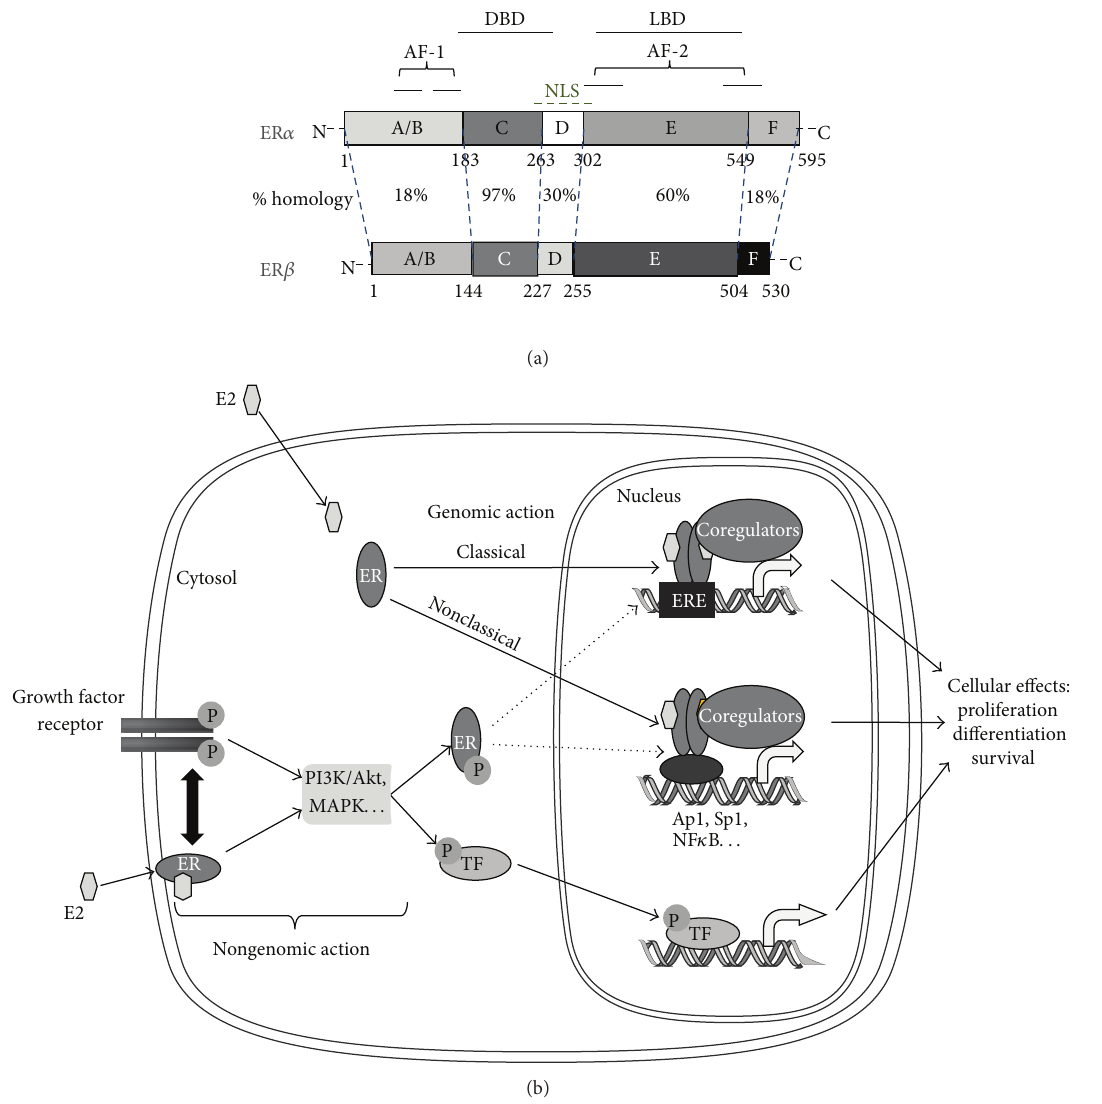
Figure 2: Structure and mechanisms of action of estrogen receptors. (a) ER 𝛼 and ER 𝛽 have an evolutionary conserved modular structure. The percentages of homology between the two forms are presented. The localizations of the ligand-binding domain (LBD) within the E domain and the DNA-binding domain (DBD) within the C domain are also presented. ERs possess two transactivation functions (AF-1 and AF-2), each divided into two subdomains which regulate the expression of target genes and contain a nuclear localization signal (NLS). (b) Due to its lipophilic properties, estradiol (E2) can passively enter the cell, through the lipid membranes. E2 can then bind ERs in the cytoplasm or the nucleus. ER dimers bind to the chromatin to modulate target gene expression. This mechanism corresponds to the genomic action of ERs, but ERs can also exercise nongenomic action, fast, directly in the cytoplasm. Indeed, the cytoplasmic or membrane-bound fraction of ER can induce, after E2-binding, the activation of intracellular signaling pathways independently or in association with the growth factor